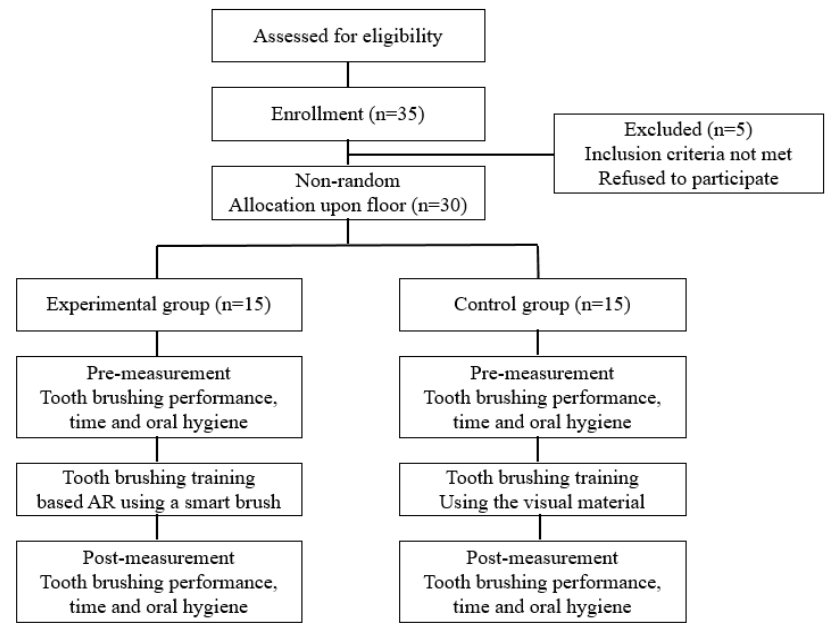
Figure 1. The schematic diagram of this study.